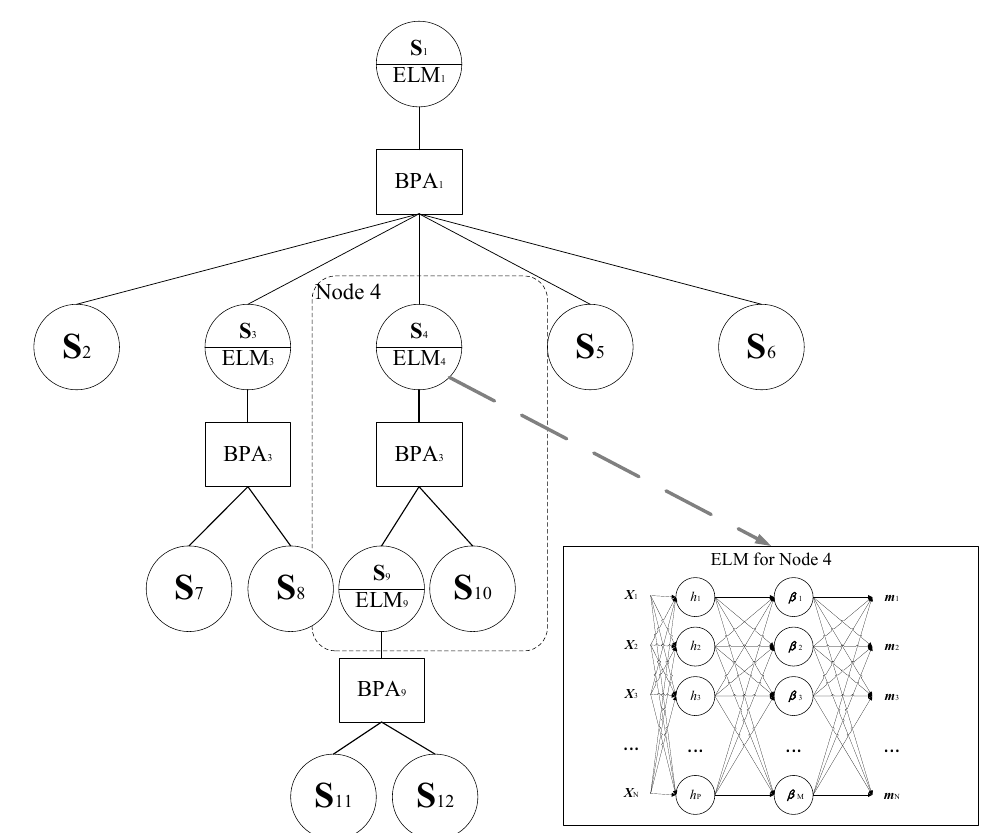
Figure 4. Fault tree of test strategy optimization based on soft sensing and ensemble belief measurement.